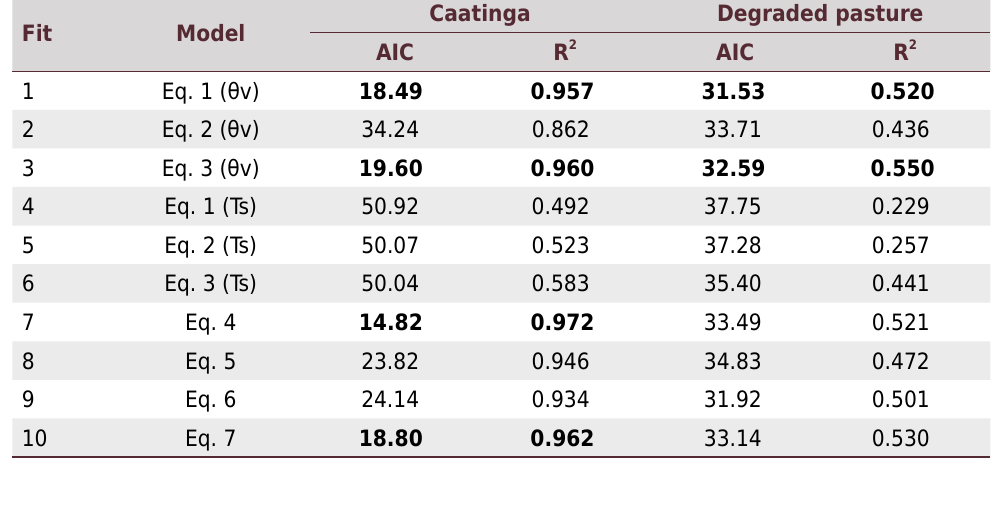
Table 3. Akaike criterion information (AIC) and coefficient of determination (R 2 ) for the models fitted to estimate soil respiration in Caatinga and degraded pasture. Bold values show the best-fitting performance